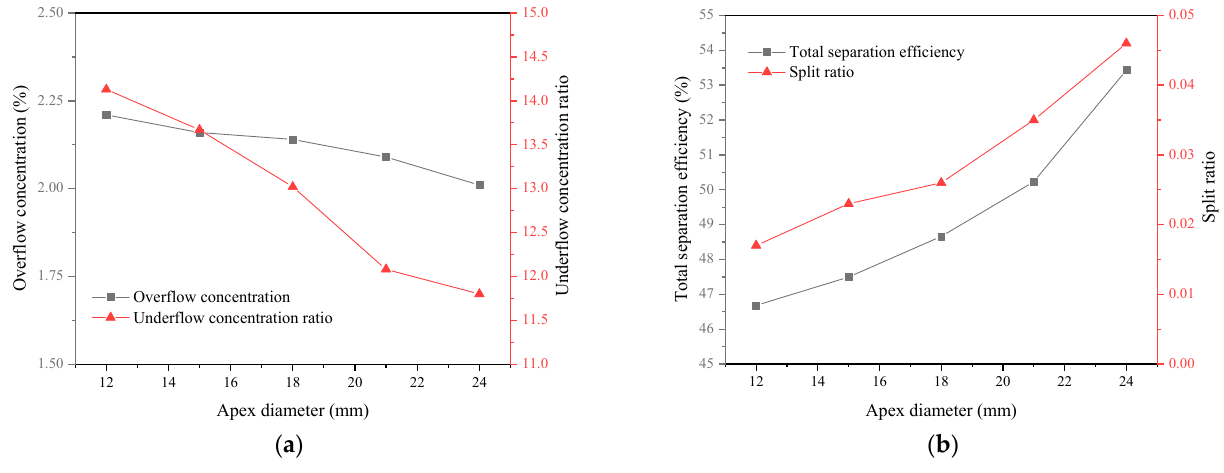
Figure 6. Effect of the underflow orifice diameter on the separation performance of the hydrocyclone. ( a ) Product concentration. ( b ) Product distribution. Table 8 indicates changes in the content of − 45 µ m particles and the comprehensive classification efficiency of the product at each outlet under different underflow orifice diameters. According to the data in the table, when the underflow orifice diameter